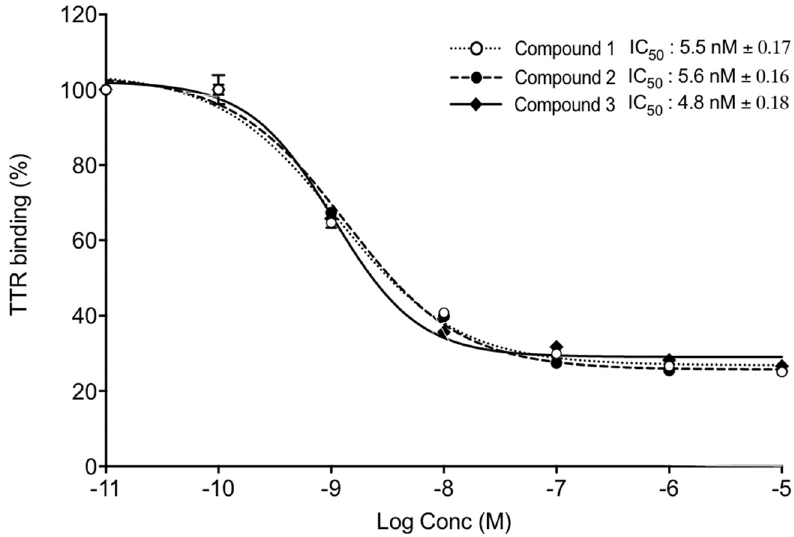
Figure 9. TTR binding assay. TTR and FITC-T 4 were mixed and incubated with different concentrations of Compounds 1 , 2 , and 3 . Competitive fluorescence binding curves (mean IC 50 ± SD) of three independent experiments. x -axis shows Log Concentrations from − 11 to − 5.